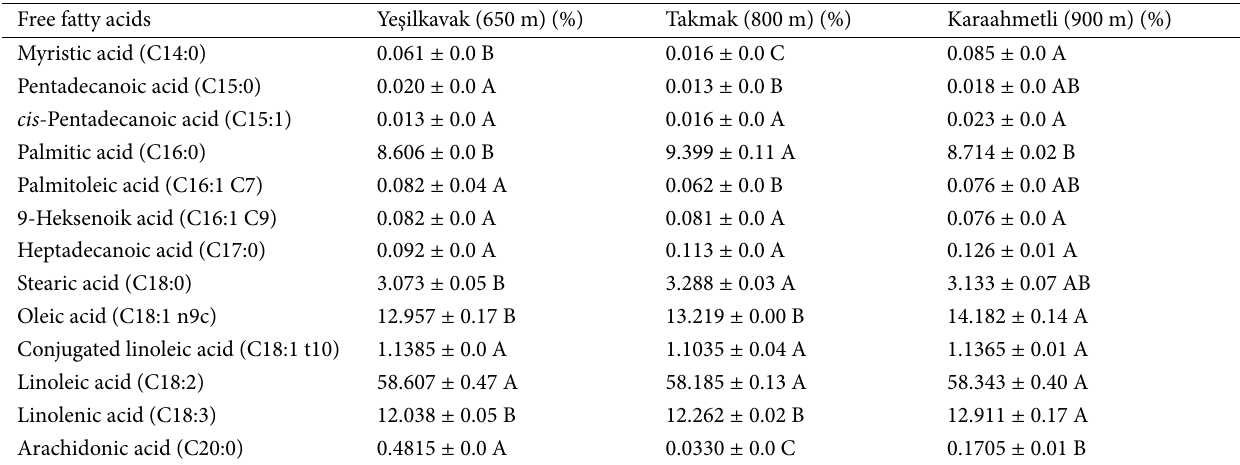
Table 4 Changes in free fatty acids of ‘Chandler’ walnuts according to growing